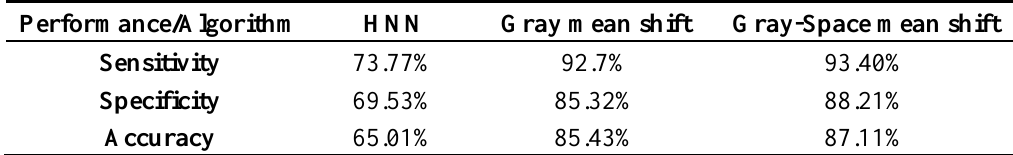
Table 3. Performance of the nucleus segmentation